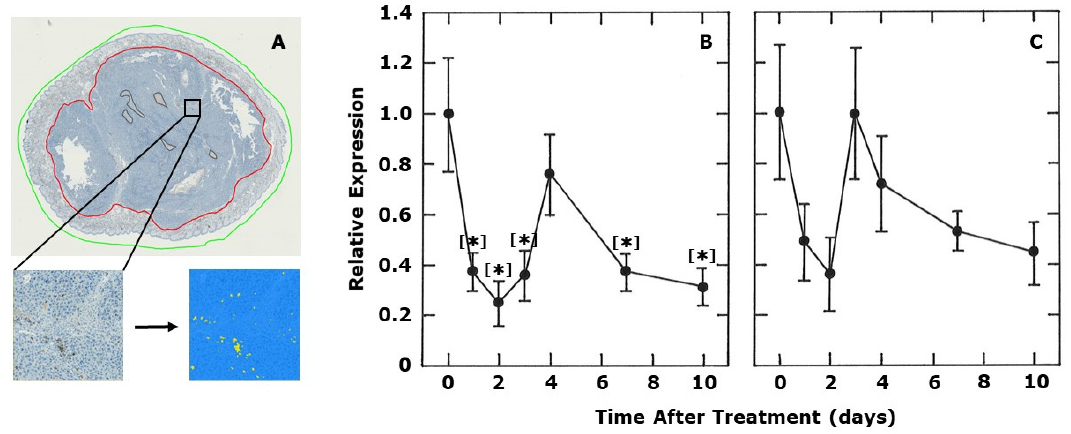
Figure 3. The effect of OXi4503 on tumor infiltrating lymphocytes. A representative tumor section to illustrate how the immune cells were quantified is shown in ( A ). The green line marks the entire tumor section, while the red line indicates the gross tumor area. Areas defined by the brown lines are necrotic regions, which are subtracted from the total tumor area in order to define the net tumor area. The brown dab-stained cells on the tumor section or in the enlarged subunit are the immune cells (CD4 + cells in this example). This image is automatically converted to a binary image, with the immune cells appearing yellow among the blue colored HE-stained cells as shown. Quantitative estimates of the relative levels of CD4 + ( B ) or CD8 + ( C ) determined from immunohistochemistry are shown as a function of time after treating 200 mm 3 C3H mammary carcinoma bearing CDF1 mice with a single dose of OXi4503 (50 mg / kg). Results show means ( ± SEM) for at least 6 mice / group. Statistical comparisons were made using a Student’s t -test and show those groups that were significantly di ff erent ( p < 0.05) from controls [*].